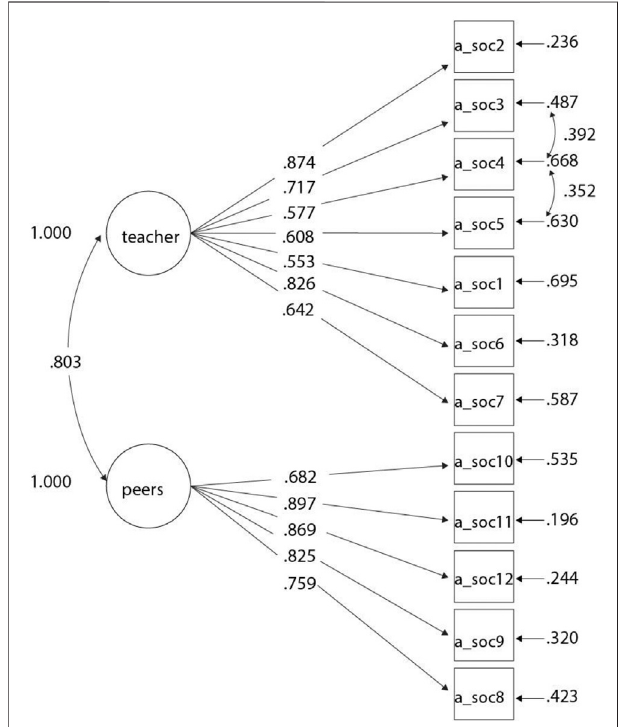
FIGURE2| Showsresultsfromacon fi rmatoryfactoranalysisofathree- factormodelwithgood fi t.Standardizedfactorloadingsarelargelyacceptable except for item 8 (items loads 0.419 and 0.418 on two factors, the item is “ Behaves appropriately outside the classroom ” ). Acceptable standardizedfactorloadingsfortheteacherfactorrangesfrom0.538to0.877 (Cronbach ’ s scale alpha (cid:1) 0.778), work ranges from 0.599 to 0.736 (Cronbach ’ s scale alpha (cid:1) 0.847), and for peer ranged from 0.418 to 0.904 (Cronbach ’ s scale alpha (cid:1) 0.897). The latent correlations between these factors are positive and signi fi cant and range from 0.735 to